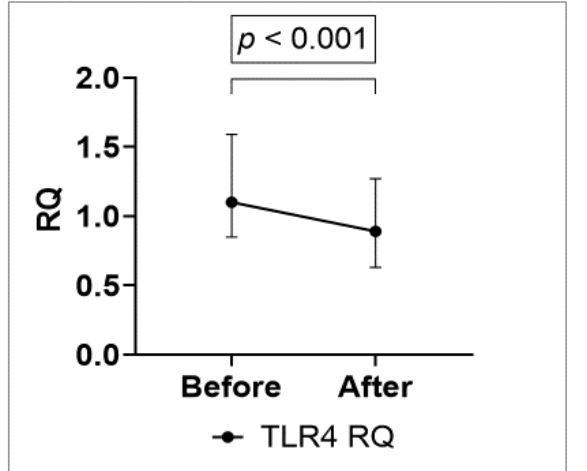
Figure 2. Change in relative gene expression of TLR4 from before to after exercise in a subset of patients ( n = 101).